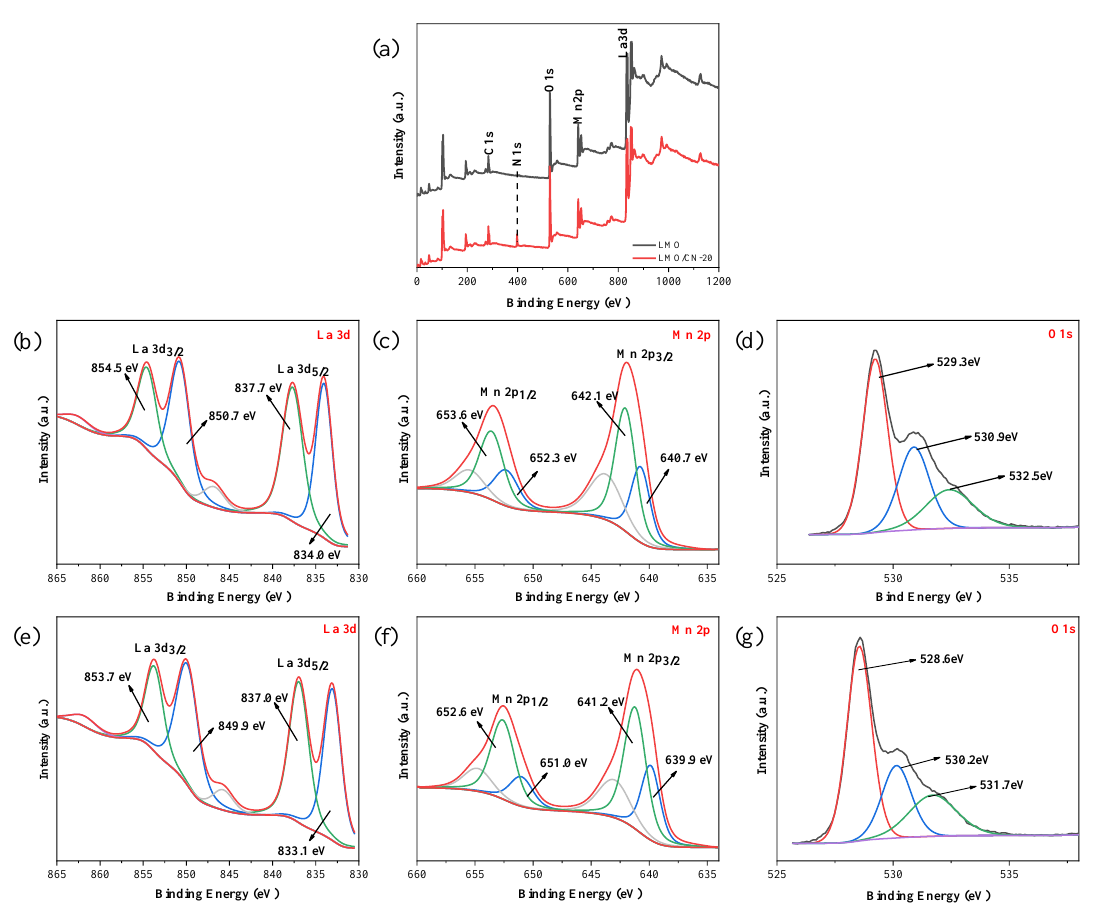
Figure 3. XPS spectra of LMO and LMO/CN-20 ( a ), LMO La 3d ( b ), Mn 2p ( c ), O1s ( d ); La 3d ( e ), Mn 2p ( f ), O1s ( g ) of LMO/CN-20.